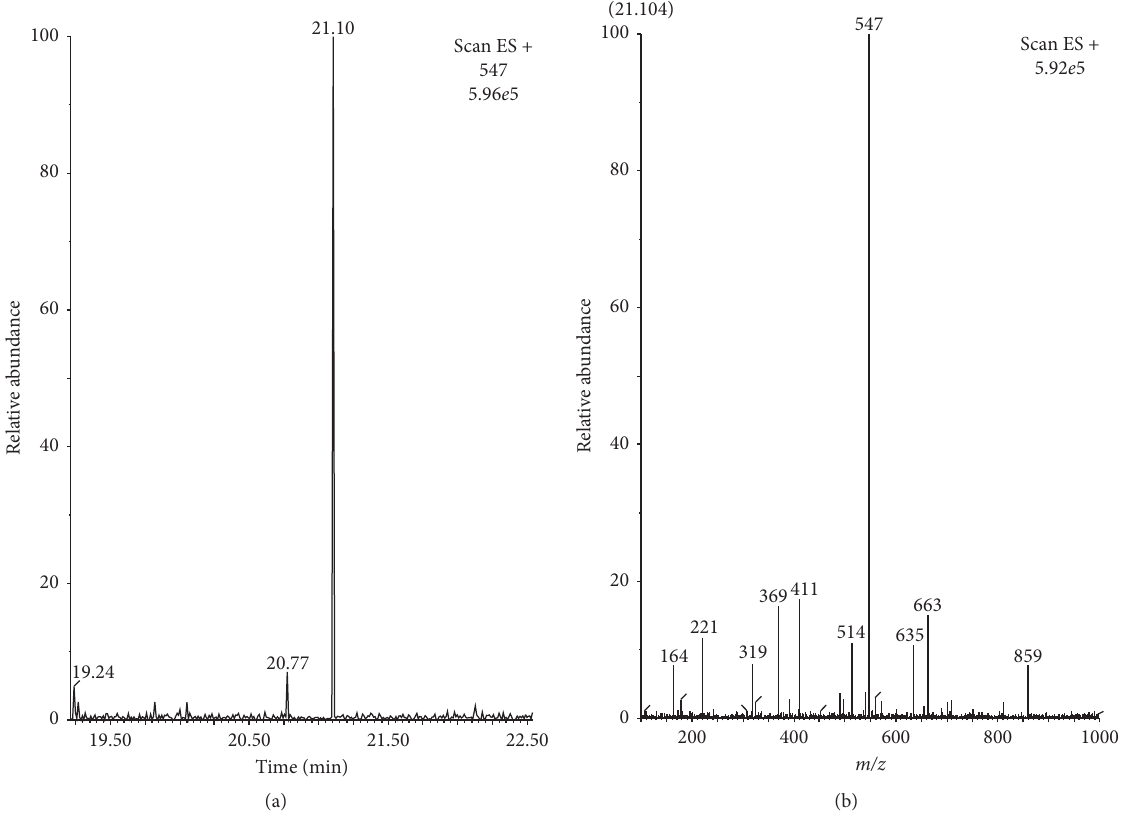
Figure 3: Extracted ion chromatogram (a) and the corresponding mass spectrum (b) based on the protonated molecular ion at m / z 547 that could arise from Schiff’s base 8 and/or the corresponding Schiff’s base derived from secosterol aldehyde 3